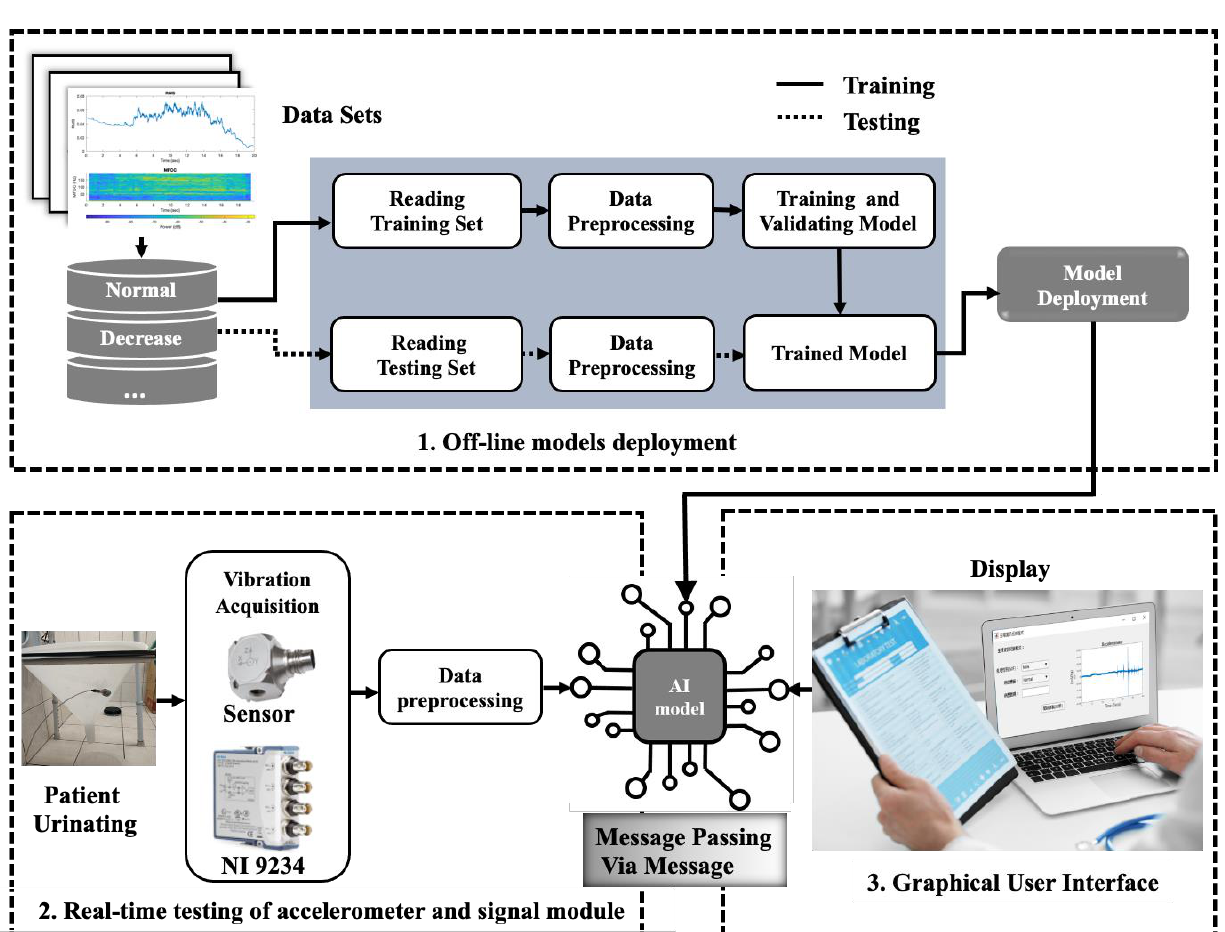
Figure 2. The components and architecture of the prototype system.